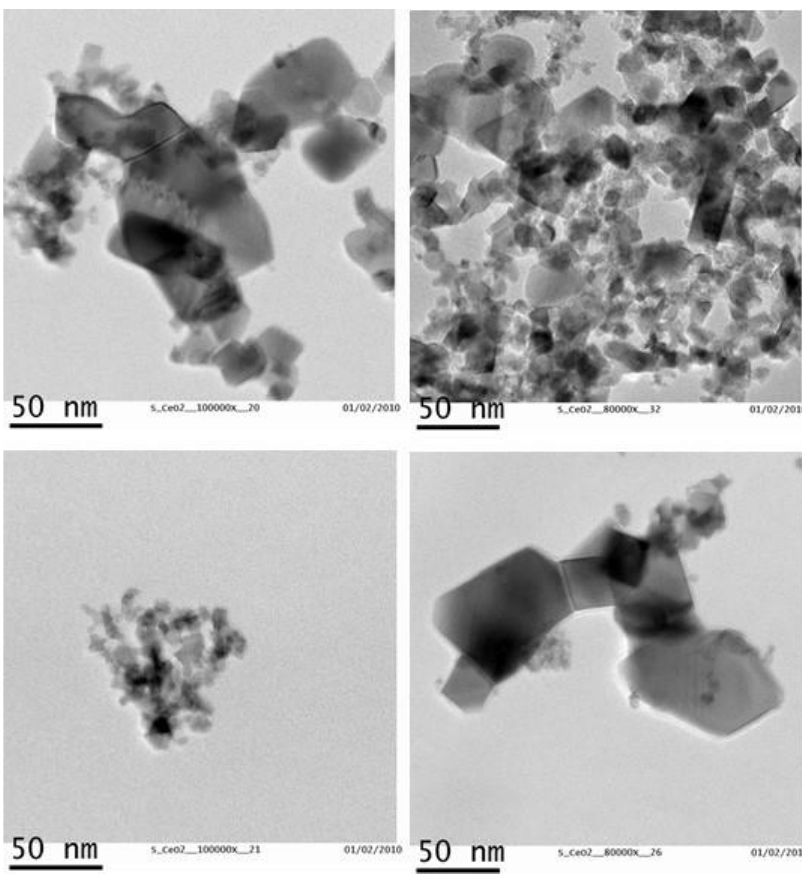
Figure 1. TEM images showing CeO 2 -NPs.